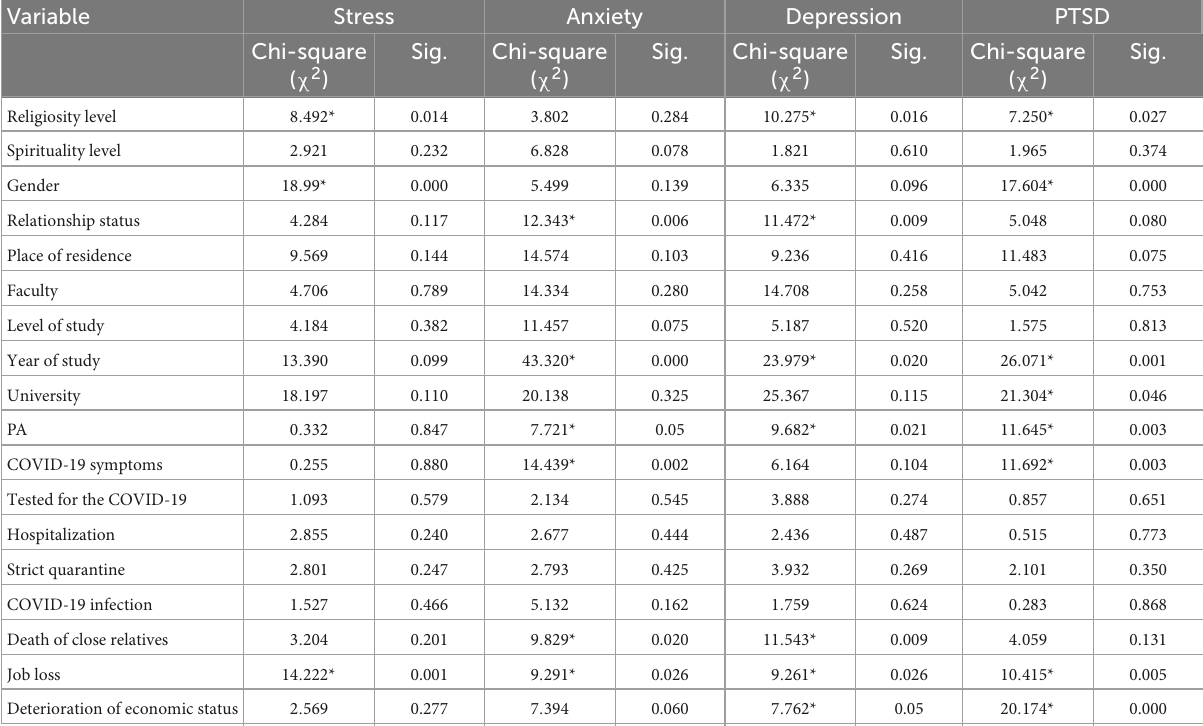
TABLE 5 Predictors of models from a socio-interpersonal perspective by multinomial logistic regression. Variable Stress Anxiety Depression PTSD Chi-square Sig. Chi-square Sig. Chi-square Sig. Chi-square Sig. ( χ 2 ) ( χ 2 ) ( χ 2 ) ( χ 2 )